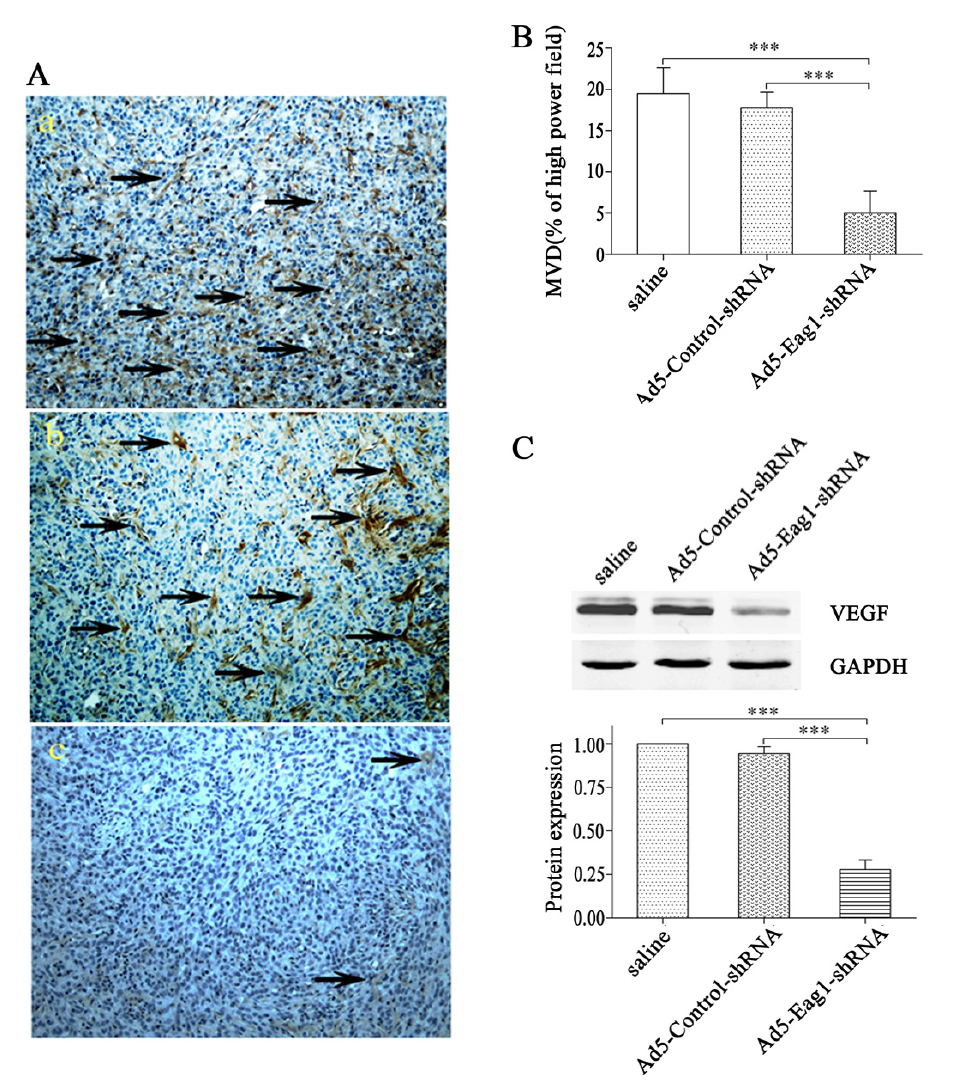
Figure 3. Eag1 silencing reduces intratumoral blood vessels in osteosarcoma-bearing mice. ( A ) 12 days after nude mice receiving injections of saline ( a ), Ad5-Control-shRNA ( b ) or Ad5-Eag1-shRNA ( c ), respectively, the mice were sacrificed. Blood vessels in the microphoto-graphs were marked by a yellow brownish color (anti CD31, black arrow). ( B ) Quantification of the intratumoral MVD by measurement of CD31 in 10 high power fields. *** p < 0.001. ( C ) VEGF expression in tumor tissues of nude mice was detected by Western blot analysis. Grey-value analysis was completed using GAPDH as the internal reference, and the results were expressed as mean ± SD ( n = 3). *** p <